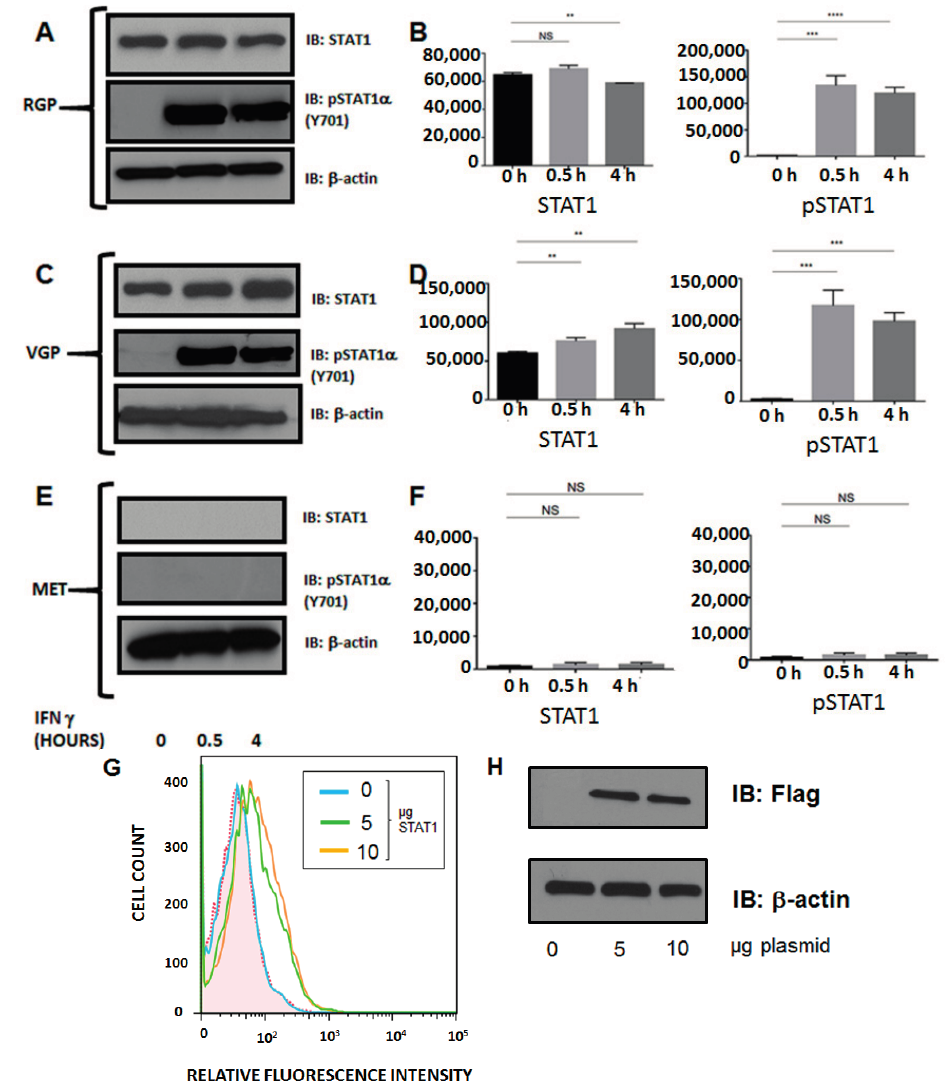
Figure 6. Western blot analysis of STAT1 expression and phosphorylation. Cells were stimulated with IFN- γ for 0, 0.5 or 4 h. Lysates were cleared of cellular debris, and equal concentrations of protein were separated via SDS-PAGE. Proteins were identified by incubating nitrocellulose with antibodies against STAT1 (RGP, VGP, MET; top) or pSTAT1 (RGP, VGP, MET; middle). β -Actin was used as a loading control (RGP, VGP, MET; bottom). ( A , B ) STAT1 is constitutively expressed and phosphorylated at tyrosine 701 (Y701) following 30 minutes of IFN- γ stimulation in RGP cells; ( C , D ) STAT1 expression and phosphorylation in VGP cells is similar to RGP; ( E , F ) STAT1 expression is absent in MET cells. The data shown are representative of at least three experimental replicates. y -axes ( B , D , F ) represent Total Pixels (Quantification of A , C , E ). NS: Not Significant; ( G ) MET cells + STAT1. MET cells were transfected with 0, 5, 10 µg of Flag-STAT1 for 24 h followed by 48 h of IFN- γ stimulation. Cell surface expression of MHC II was analyzed via flow cytometry; and ( H ) Expression of Flag-STAT1 following 24 h of incubation with transfection reagent:plasmid complexes. Both 5 µg (light green) and 10 µg (orange) of STAT1 led to restoration of MHC II on the cell surface, compared to non-transfected cells (light blue) and the unstained control (shaded). ** p < 0.005, *** p < 0.001, **** p <